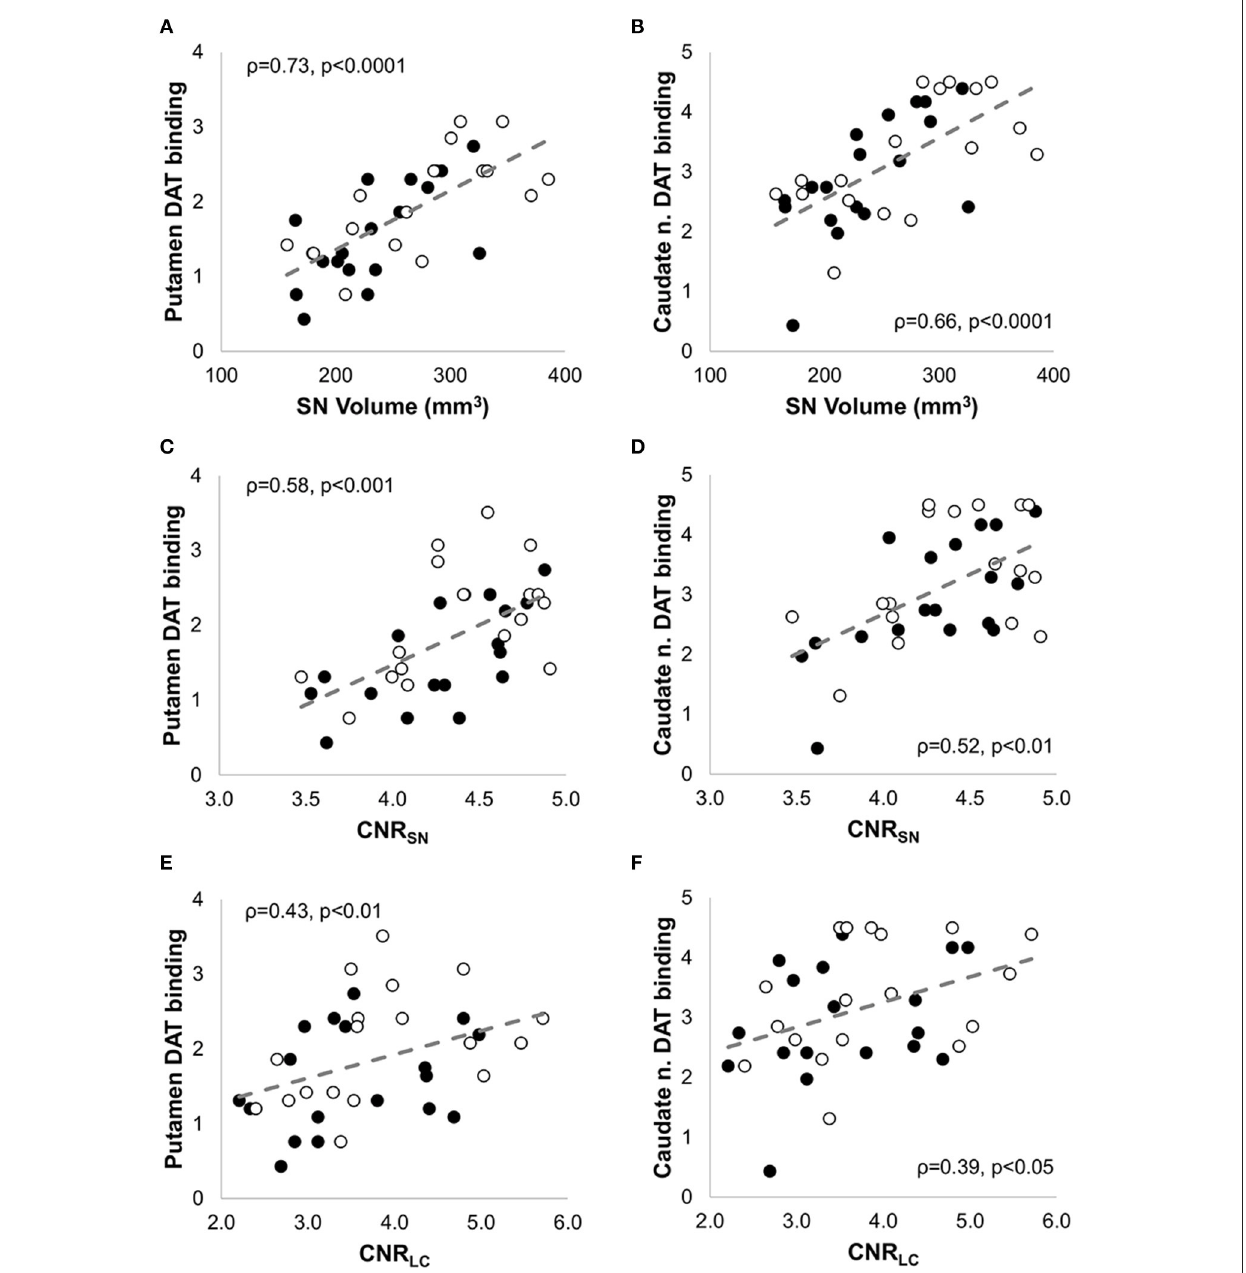
FIGURE 5 | Non parametric correlation analysis with linear regression between NM-MRI and SPECT measures in patients with PD. NM-MRI measures of the substantia nigra (SN volume and CNR SN ) and locus coeruleus ( CNR LC ) were significantly correlated with DAT binding values of the putamen (A,C,E) and caudate nucleus (B,D,F) . The Spearman correlation coefficients ( ρ ) and the p -values are indicated in each figure. The filled circles correspond to the measurements in the contralateral side, and the empty circles to the measurements in the ipsilateral side.